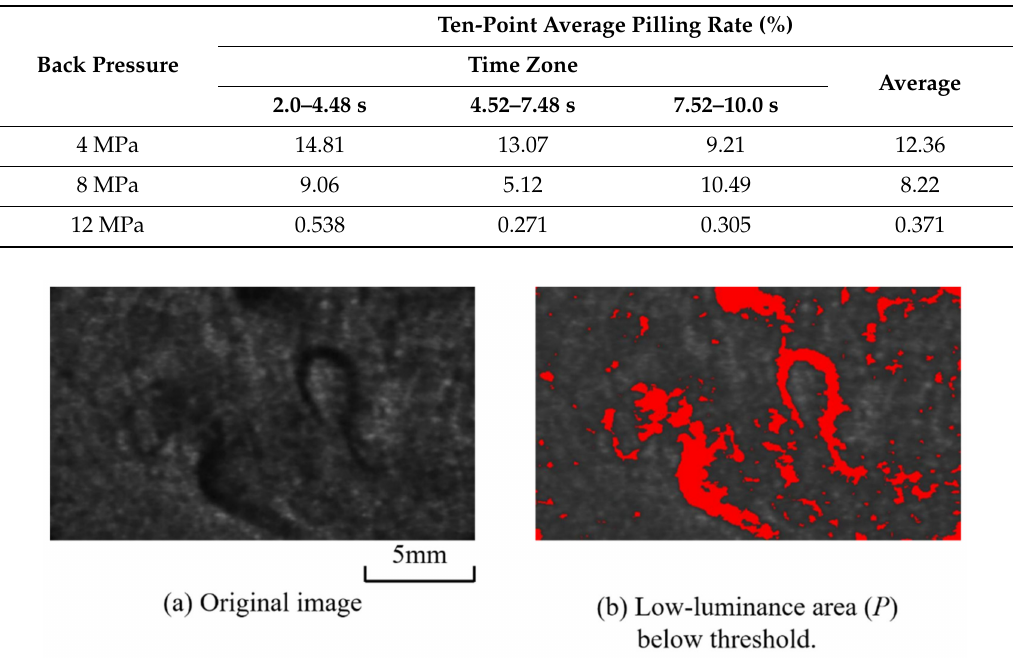
Figure 7. Calculation procedures of pilling area P (BP = 4 MPa, Shot No. 1, 6.12